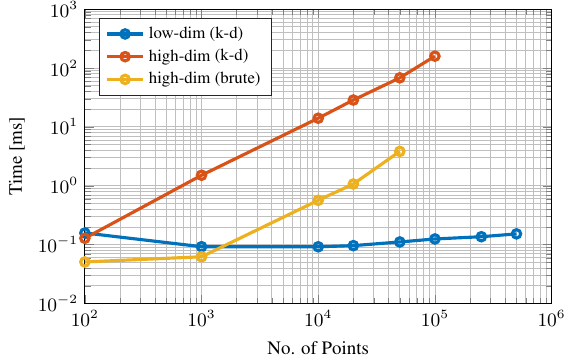
Figure 7. Time needed for querying the nearest neighbor of one point in the